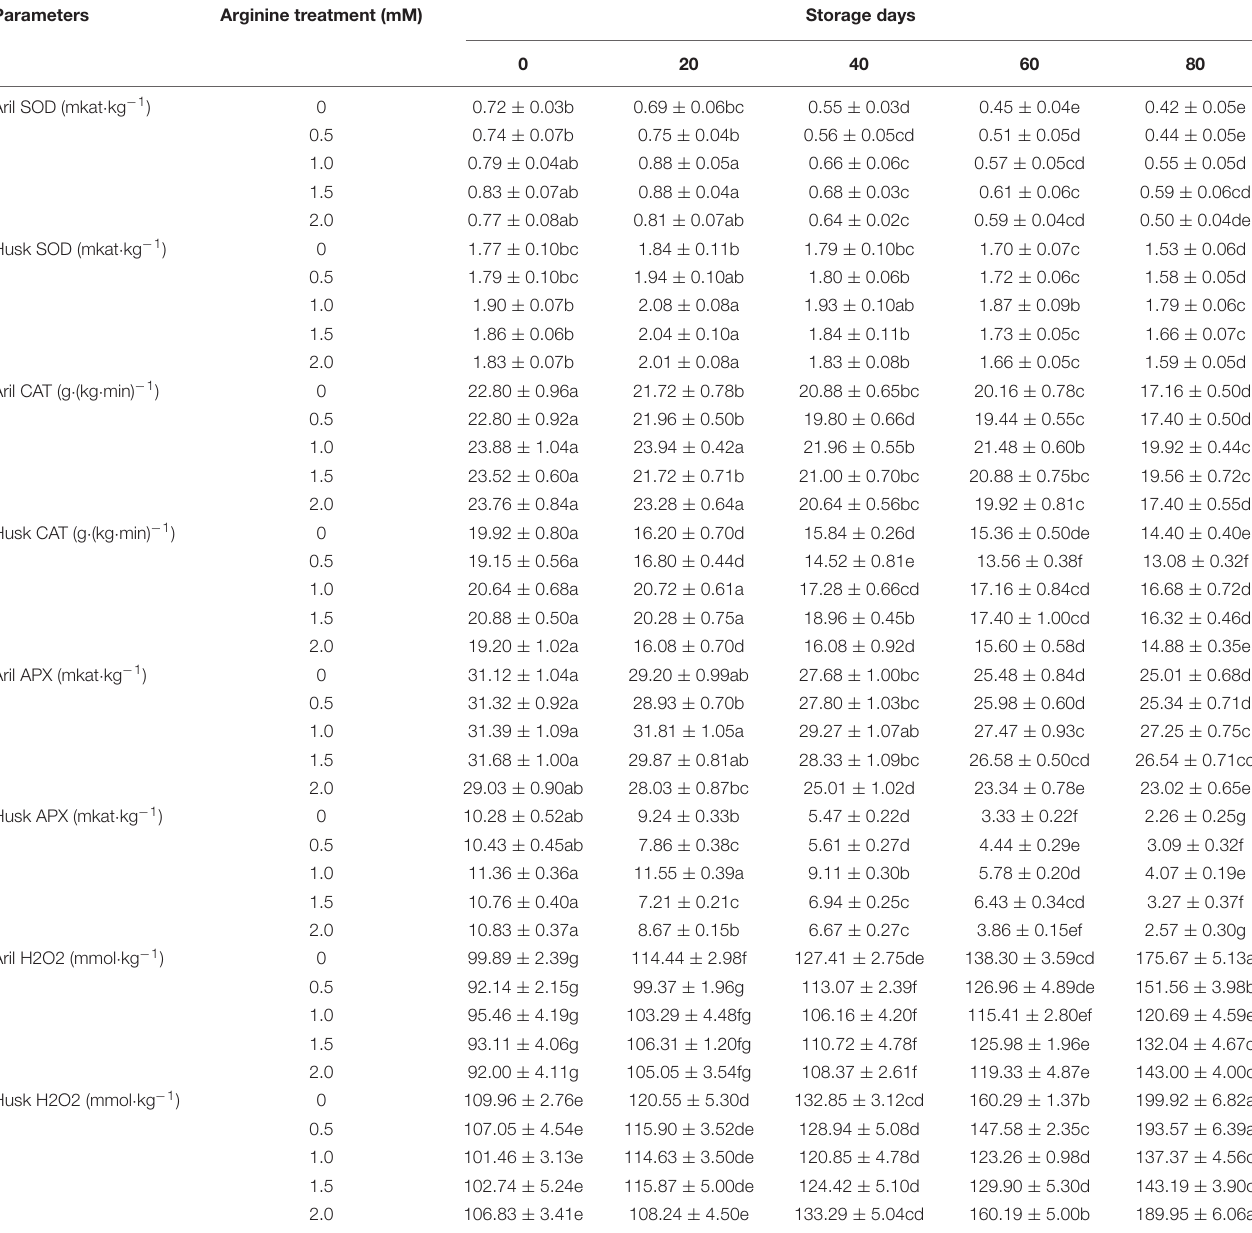
TABLE 1 | Enzyme activities of SOD, CAT, APX, and H 2 O 2 content in Tunisia husks and arils during cold storage at 4 ± 0.5 ◦ C.